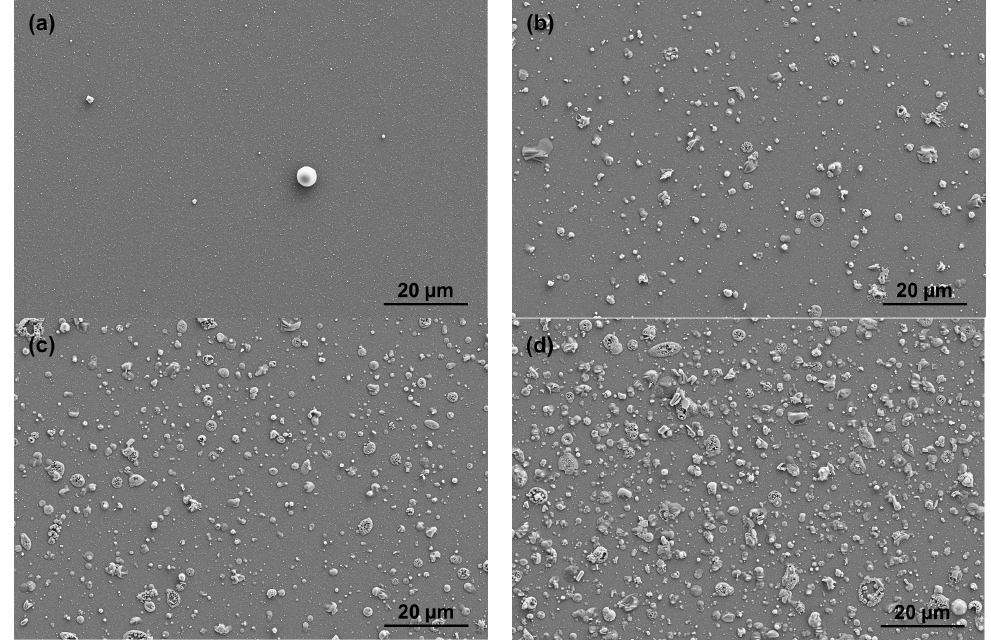
Figure 1. SEM micrographs of the surface topography of Zn-SiO x films grown on Si with secondary precursor flow rates of ( a ) 0, ( b ) 25, ( c ) 50, and ( d ) 100 µl/min.